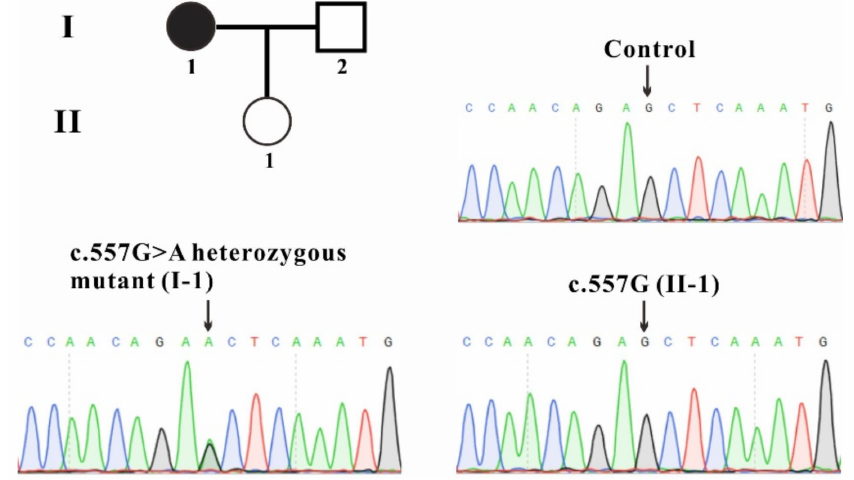
Figure 1. Family pedigree and sequencing results. The patient involved in this study is shown as filled circles. Sanger sequencing results from the patient (I-1), her daughter (II-1) and a healthy control were shown and the gene variation is indicated by a black